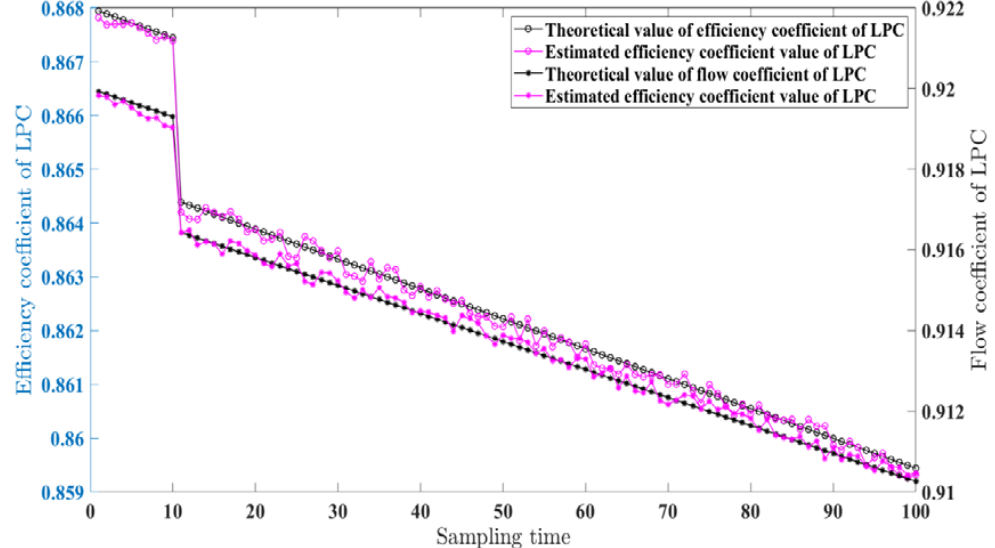
Figure 8. Estimated health parameters of low-pressure compressor in sudden change of working state.